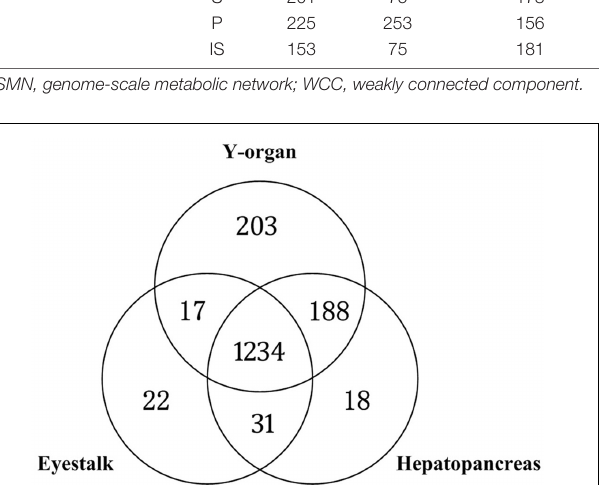
Frontiers in Genetics |